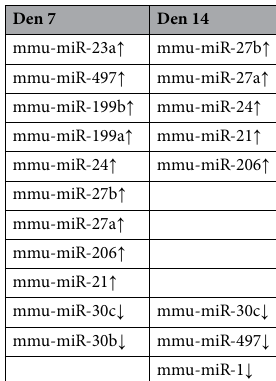
Table 4. List of key miRNAs in denervated muscle atrophy. ↓ , down regulated; ↑ , up regulated. Den 7 denervation for 7 days; Den 14 denervation for 14 days.